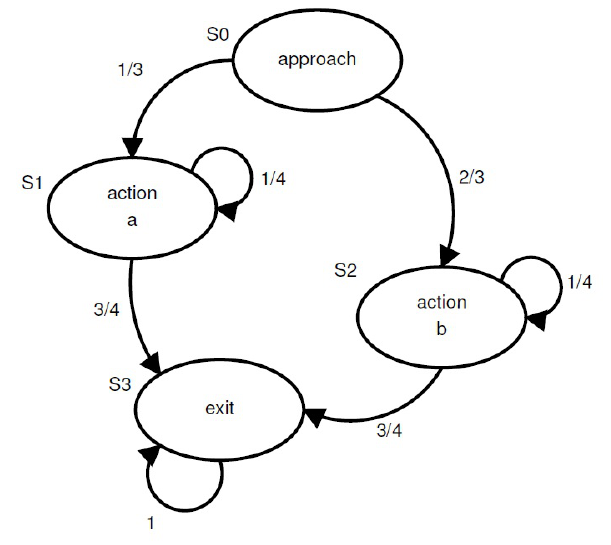
Figure 7. The Finite State Machine (FSM) model and transition probabilities for driver decisions at an intersection, where an approaching vehicle has two possible choices